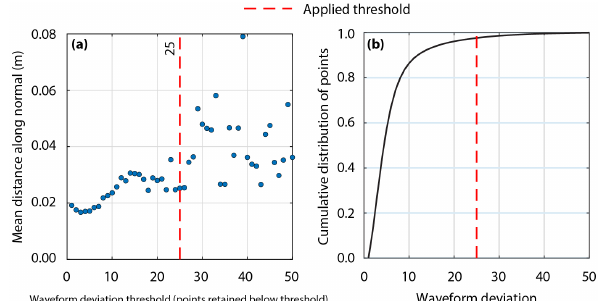
Figure 10. Sensitivity analysis for waveform deviation filter. (a) Mean absolute distance between two point clouds, attributed to points of each waveform deviation, from 1 to 50. Similar to Fig. 9, this indicates the comparison uncertainty between both scans. Error increases from ∼ 0.03 to 0.06m at values >25. The variability in error also increases such that the selection of an appropriate thresh- old >25 is not possible. (b) Cumulative distribution of waveform deviation values. A threshold of 25 removes 2% of